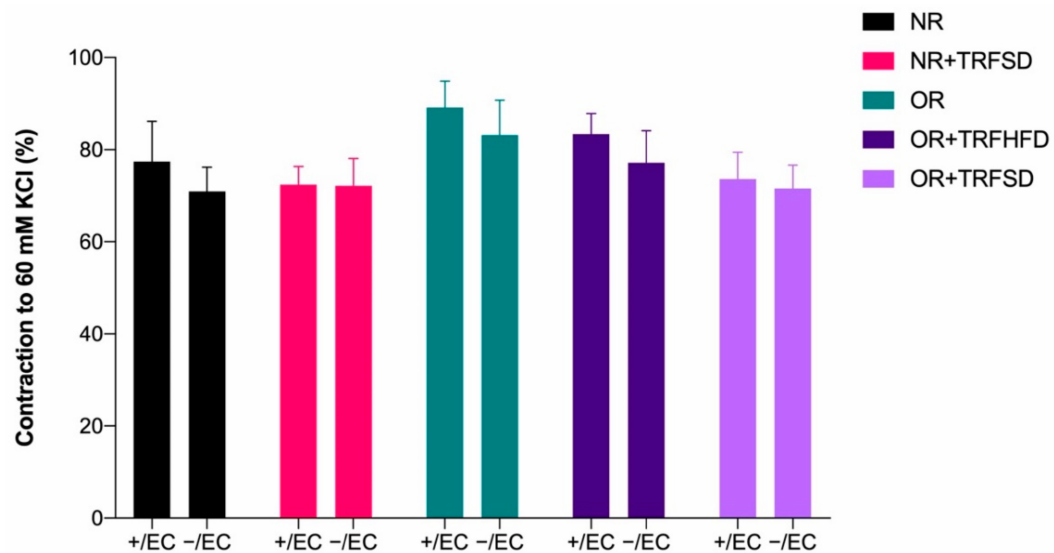
Figure 2. Contractions to KCl (60 mM) in thoracic aorta of rats. + /EC: endothelium-dependent; − /EC: